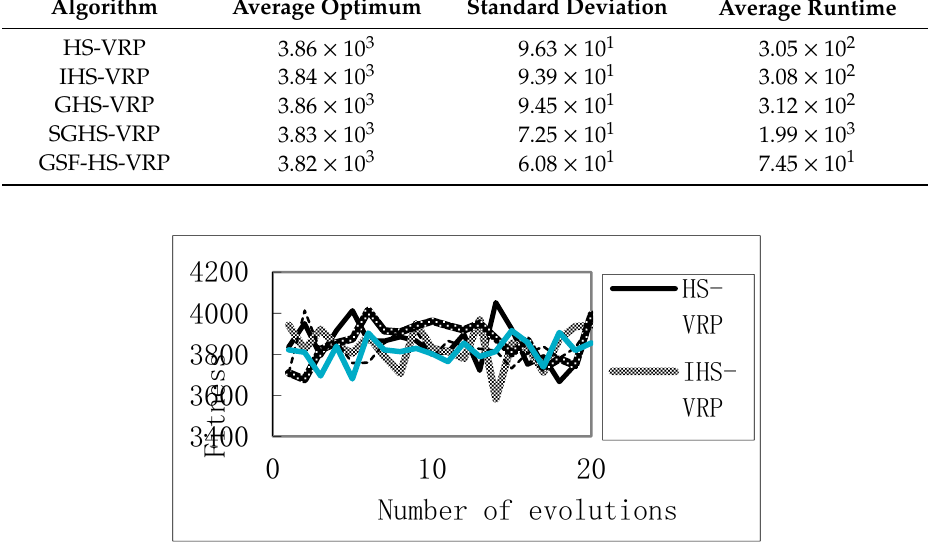
Figure 5. Average optimum iteration curve of each algorithm.